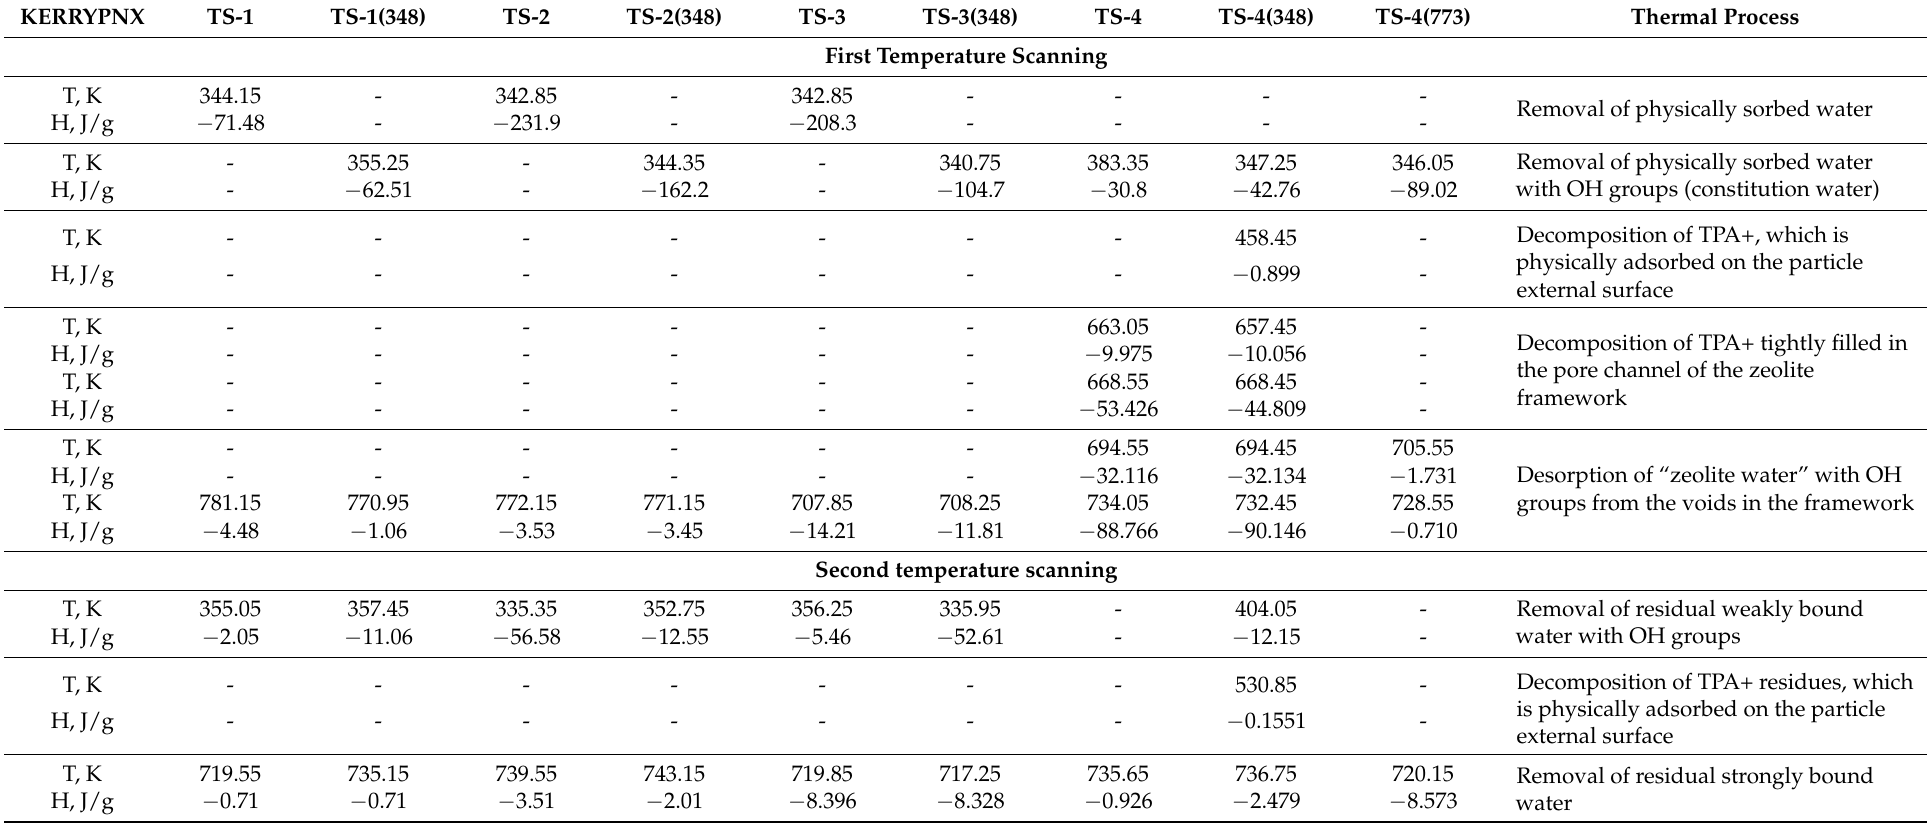
Table 12. Correspondence of peaks (T, K) in the DSC thermograms to possible thermal processes (data from